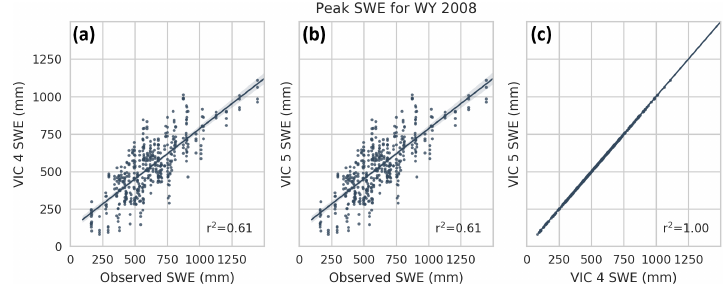
Figure 2. Example summary figure from the VIC-5 SNOTEL science tests. Panels (a) and (b) compare observed snow water equivalent (SWE) from SNOTEL sites to simulated SWE from VIC-4 (a) and VIC-5 (b) . Panel (c) compares the results from the two VIC versions.